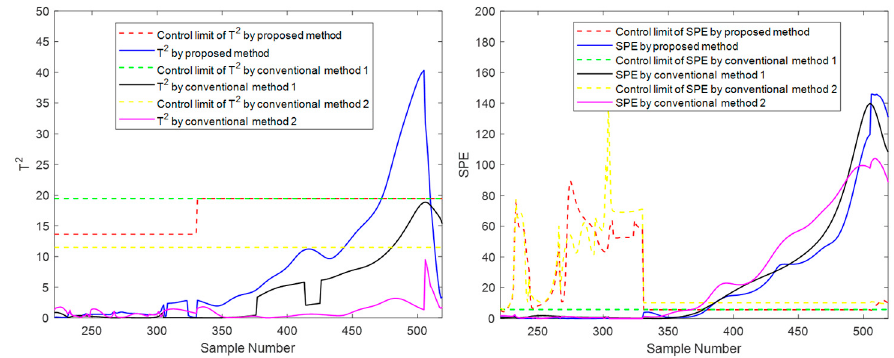
Figure 15. Online monitoring and fault diagnosis of batch 11 after introducing the fault.